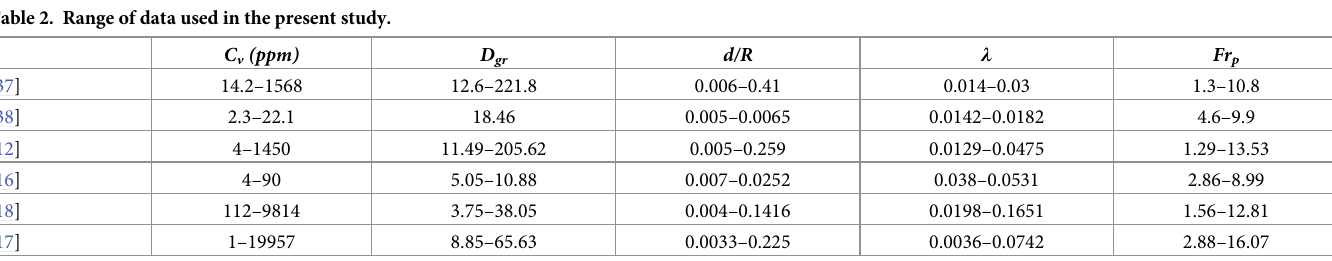
Table 2. Range of data used in the present